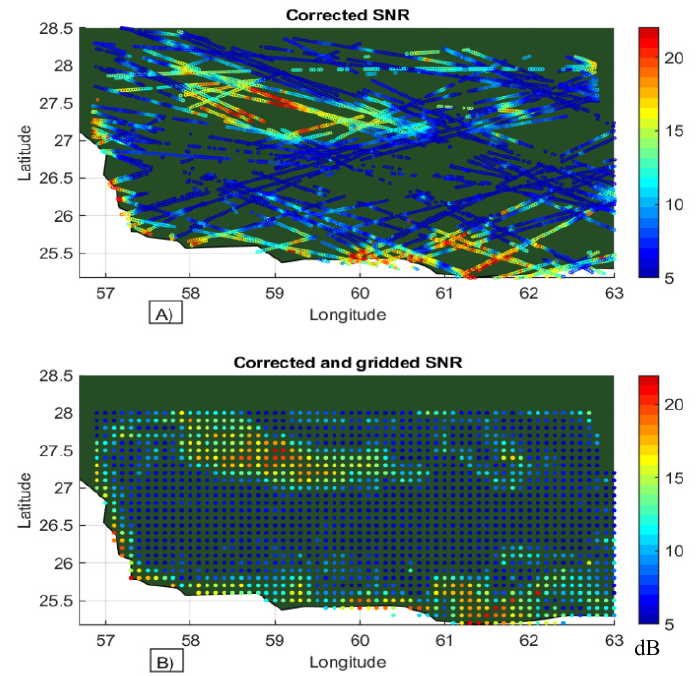
Figure 9. The outcome of the interpolation process for the corrected SNR ( SNR c dB ) over the period of three days from 13 January to 15 January 2020. ( A ) Representation of the CYGNSS measurements along the satellite tracks, ( B ) the interpolated data at 0.1° × 0.1° grid points using the natural neighbor interpolation method.